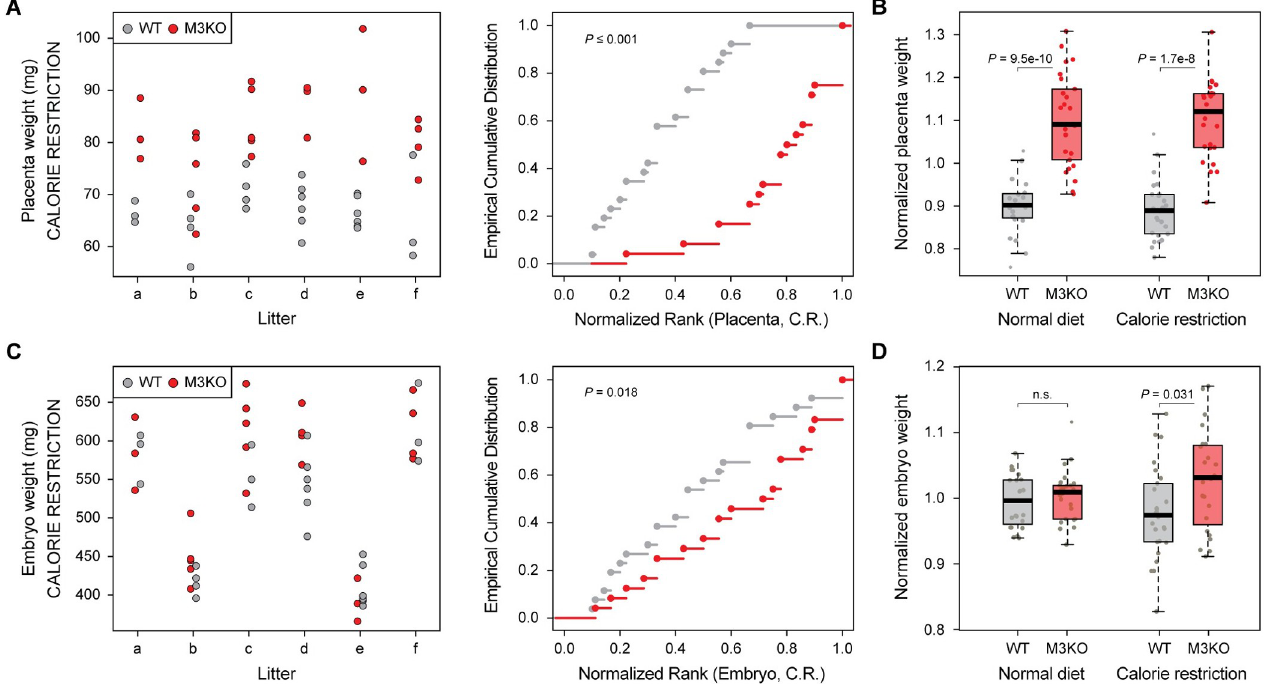
Fig 5. M3KO reduces the effect of midgestational maternal calorie restriction on fetal growth. (A, C) Dot plots showing the weights of individual WT (gray) and M3KO (red, M3KO) placentas (A) and embryos (C) harvested from 6 calorie restricted mothers and the corresponding empirical cumulative distribution plot for each genotype. Significance levels were calculated by a permutation test with 1,000 iterations swapping the genotype labels within each litter. (B, D) Analysis of the effects of maternal calorie restriction on the weight of WT and M3KO placentas (B) and embryos (D) at E18.5. For each embryo/ placenta, the weight was normalized with respect to the average of WT and KO weights within each litter. Significance levels are calculated by Wilcoxon rank- sum tests. The numerical data underlying this figure can be found in S1 Data. KO, knockout; M3KO, Mbnl3 knockout; WT, wild-type.